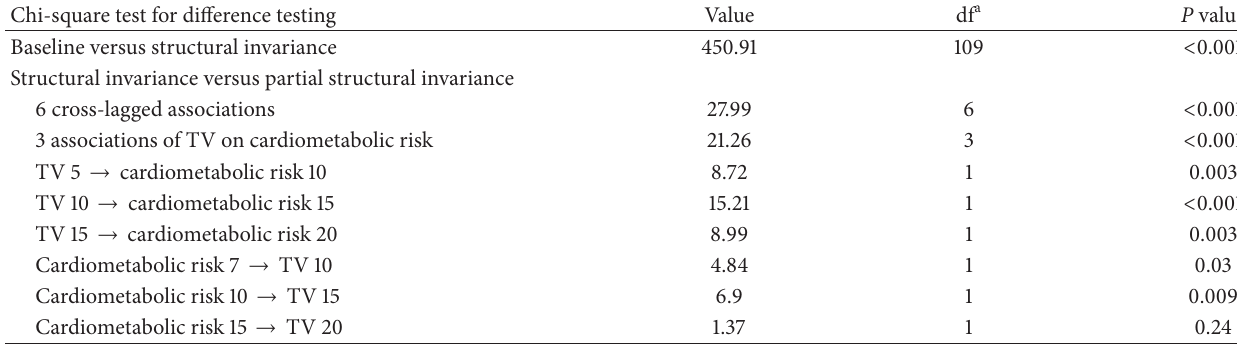
Table 4: Chi-square tests for difference testing between the low and high hostility groups, CARDIA, 1990–2005. Chi-square test for difference testing Baseline versus structural invariance